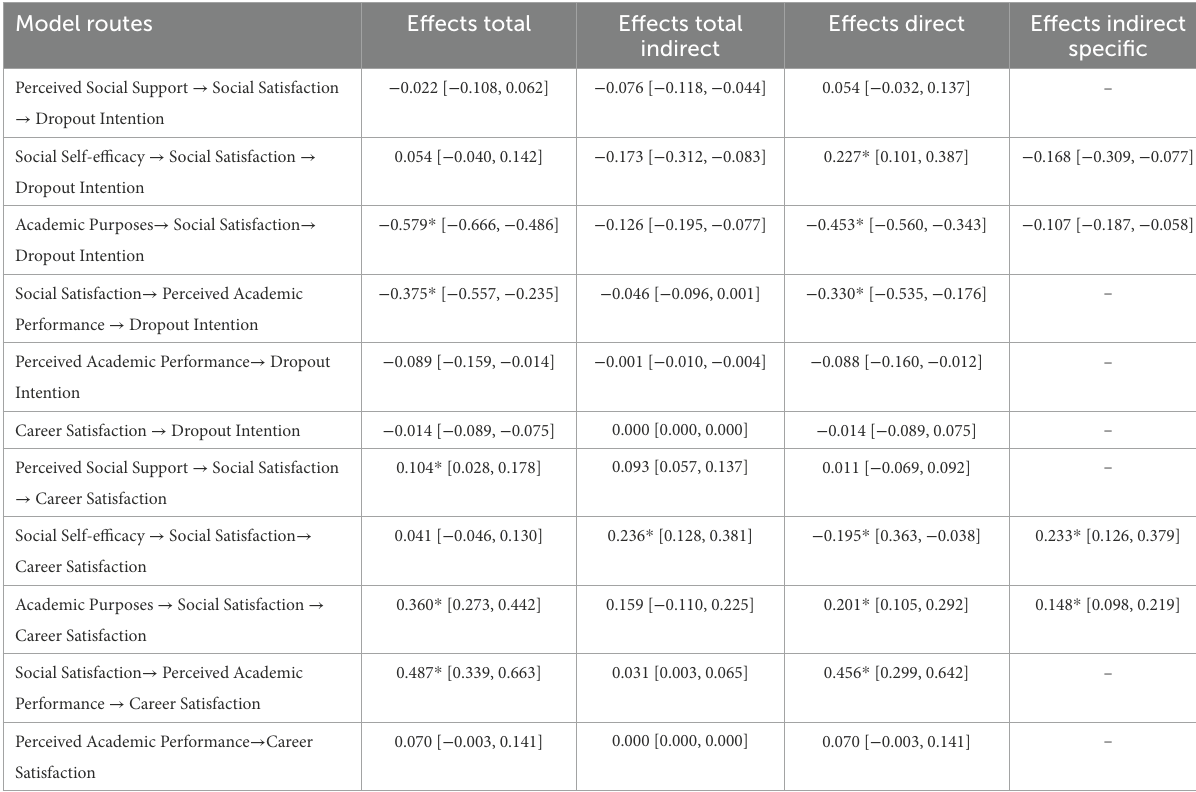
TABLE 5 Confidence intervals of standardized total, total indirect, specific indirect, and direct effects for the final